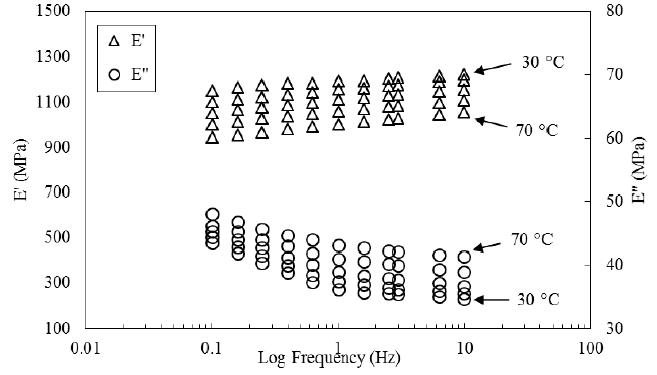
Figure 6. Frequency sweep of flax/MESS composite at different temperatures.